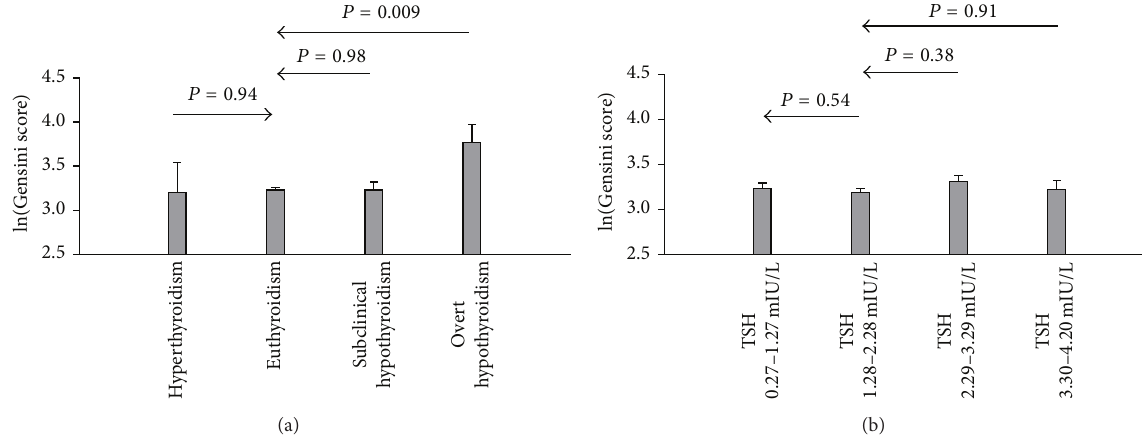
Figure 1: Severity of coronary atherosclerosis by thyroid function categories. (a) Analyses in the entire population. (b) Analyses in euthyroid individuals. Analyses were by general linear model. The dependent variable was the natural log-transformed Gensini score. Values were adjusted mean ± standard error. Multivariate adjustments were made for sex, age, BMI, hypertension, diabetes, low density lipoprotein cholesterol, high density lipoprotein cholesterol, triglyceride, smoking, and statin use. ln(Gensini score): natural log-transformed Gensini